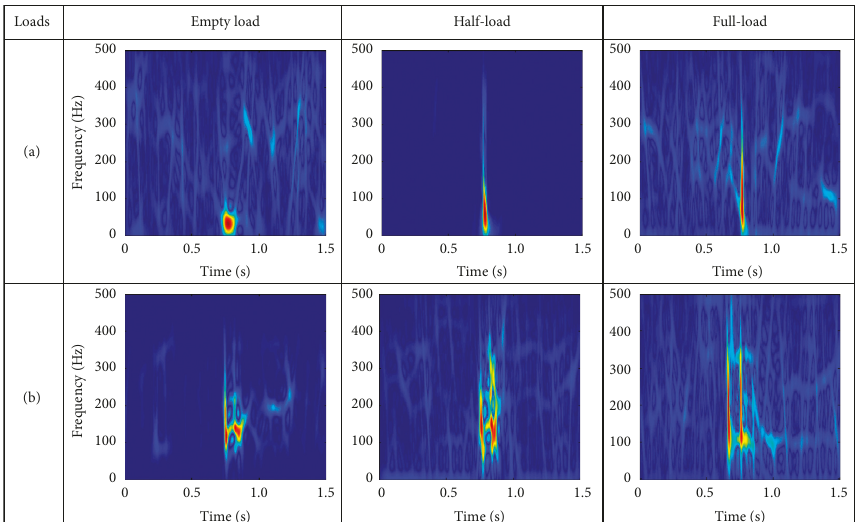
Figure 14: Time-frequency representation of vibration signals at measuring point #2 with different external loads: (a) chain jam; (b) chain